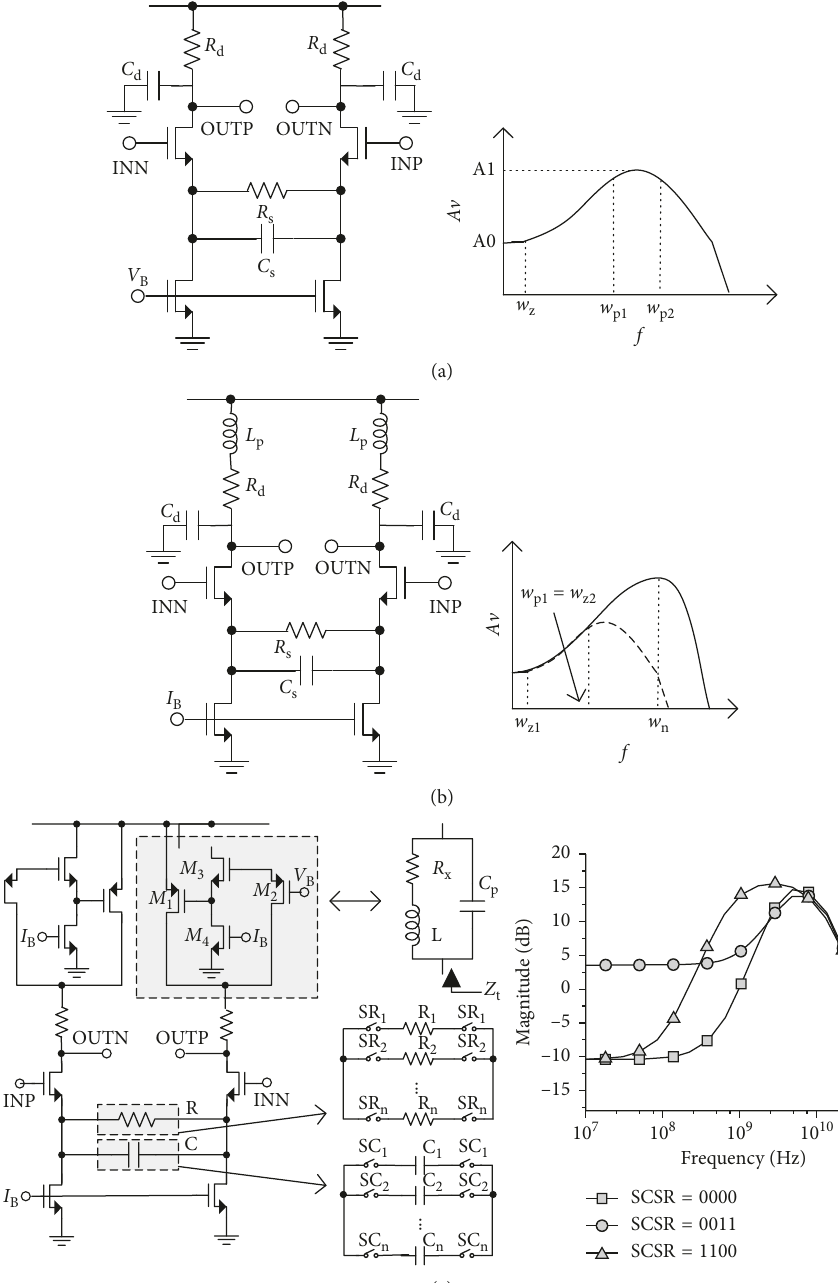
Figure 6: CTLE circuit. (a) Conventional CTLE circuit and frequency-response curve. (b) CTLE with inductor peaking. (c) Designed CTLE circuit and frequency-response